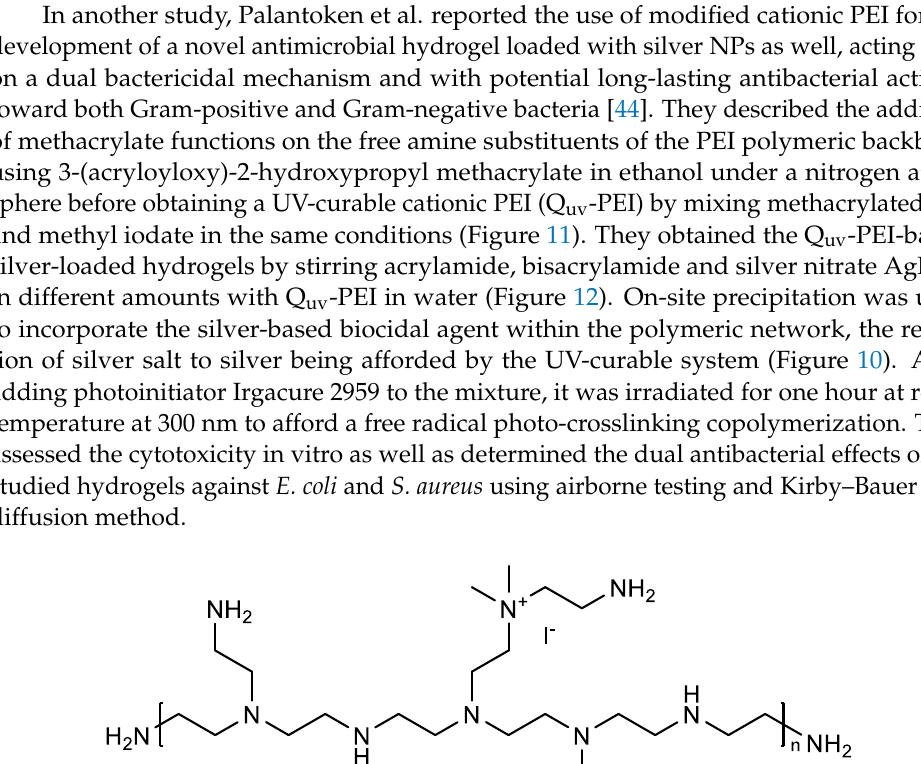
Figure 10. In situ synthesis of polymer network containing metal nanoparticles (NPs) by light- induced processes. Reprinted with permission. Copyright 2009, Wiley [65].